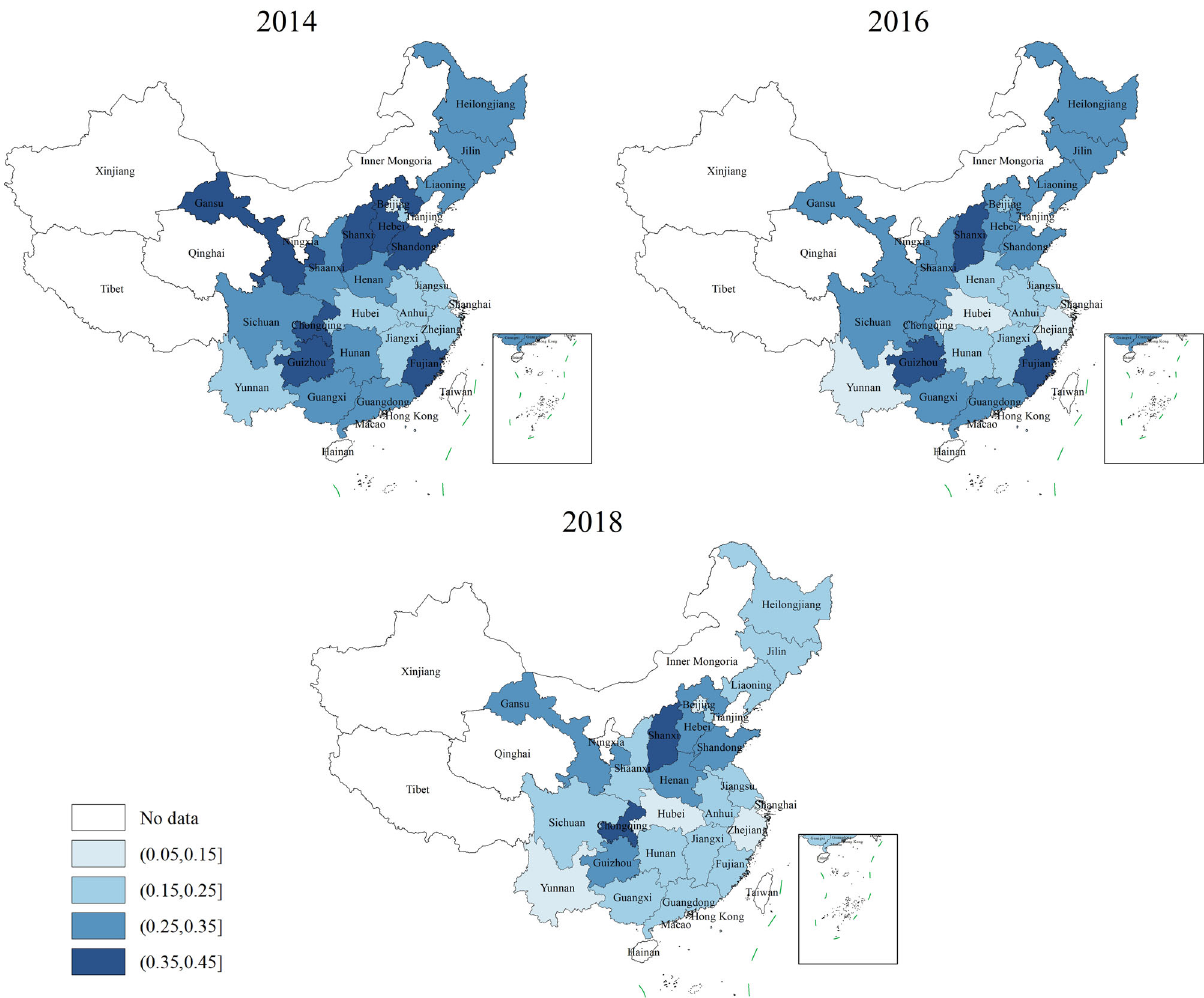
Fig. 2 EPOV in maps. The spatial distribution of EPOV in 2014, 2016, and